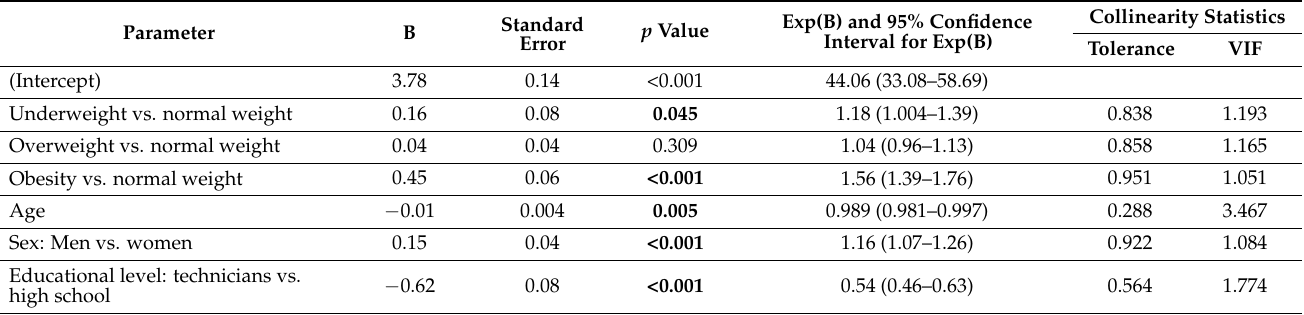
Table 4. 16th Model: general linear regression model (GLM) including multicollinearity statistics for the dependent variable carious